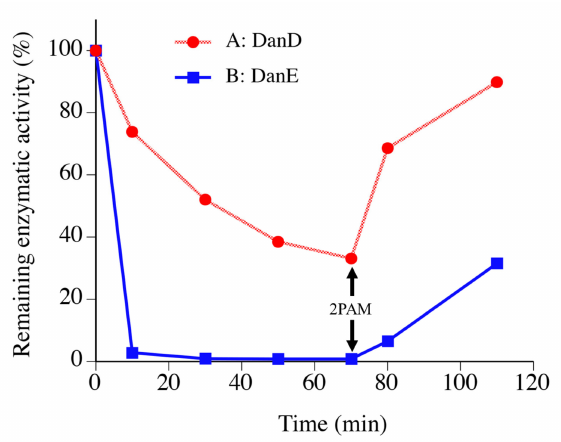
Figure 3. Changes in the remaining enzymatic activities during the modification process by using one equivalent of DanE (blue) or DanD (red) per Csin. The enzymatic activity was assayed by using Bz-L-Tyr- p NA as a substrate. The final substrate concentration was 0.2 mM. At 70 min, 2PAM was added to the reaction